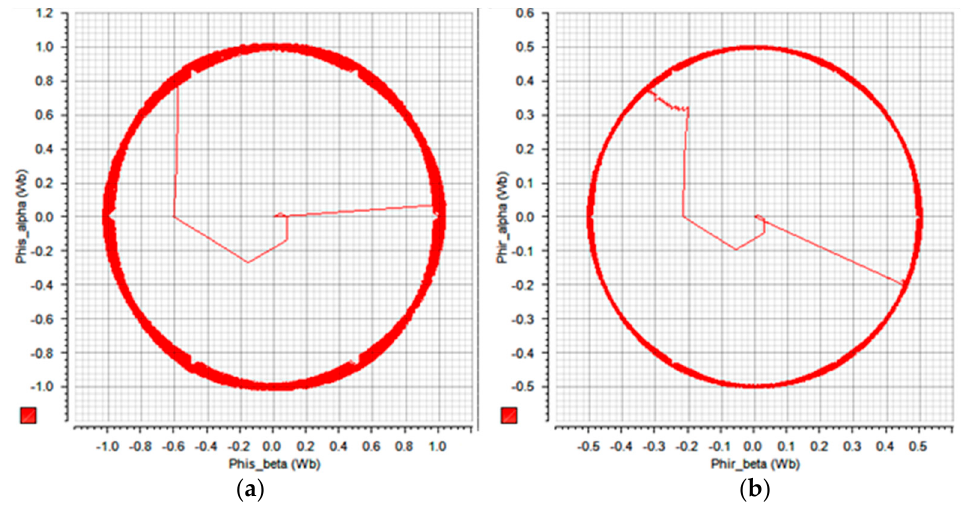
Figure 24. Isofluxes under GA–DTC: ( a ) stator and ( b ) rotor.